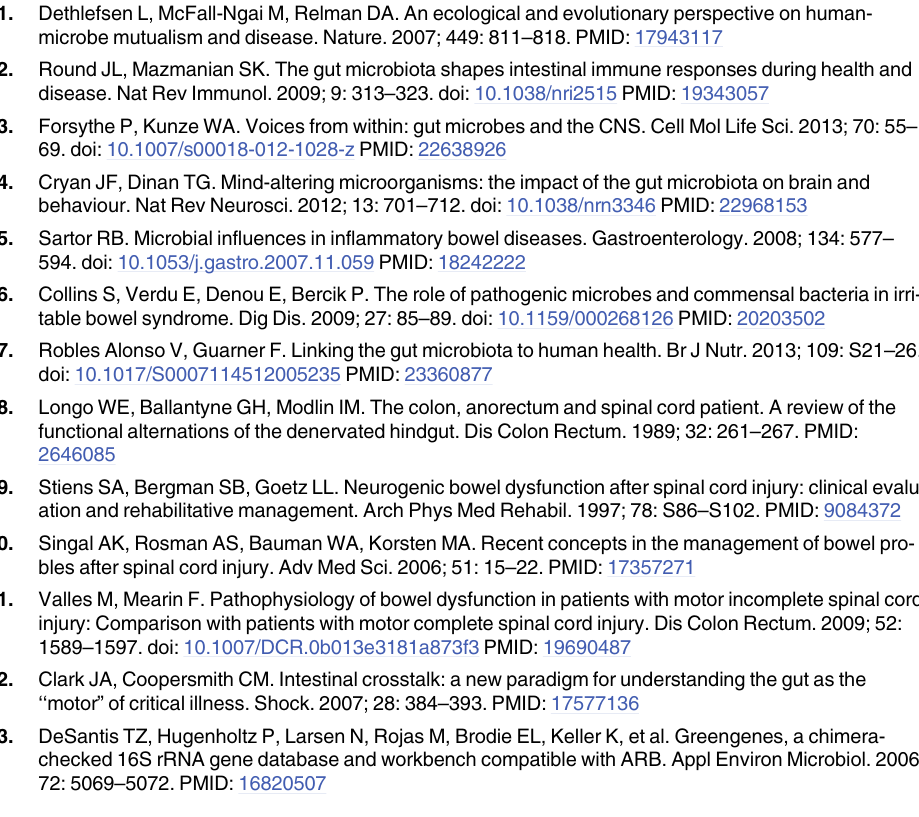
S1 Fig. Combined data with relative percentages among groups. UMN: Upper motor neuron group (Group A, N = 15); LMN: Lower motor neuron group (Group B, N = 15); and H: Healthy controls (Group C, N = 10).